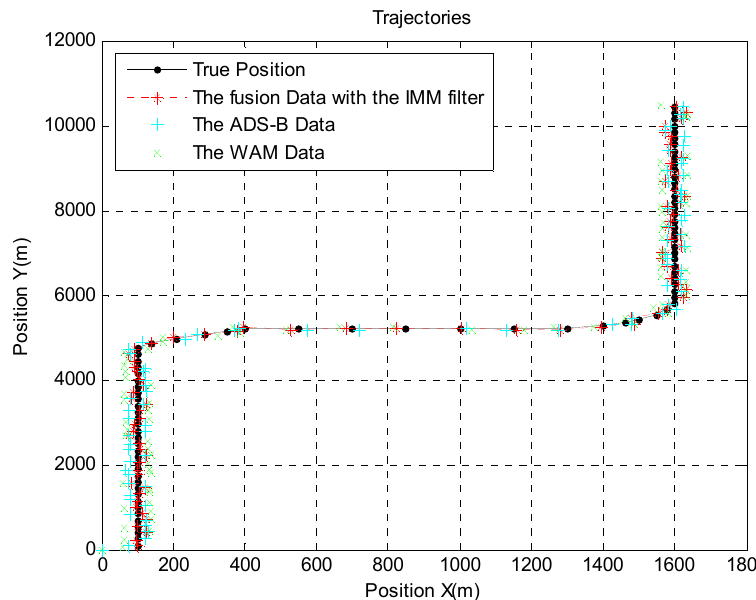
Figure 10. Aircraft trajectory at 192 km from the